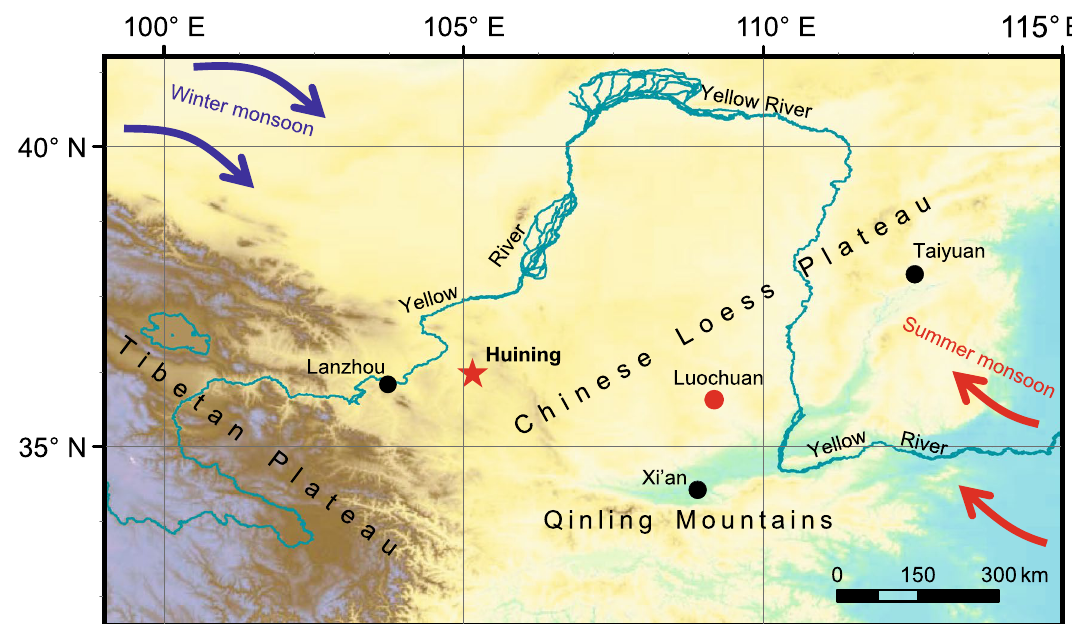
Figure 1. Locations of the Chinese Loess Plateau and the studied section. The red star denotes the location of the Huining loess–paleosol sequence. The black and red solid circles denote locations of major cities and the Luochuan section, respectively. The blue arrows indicate the direction of the East Asian winter monsoon, and the red arrows the East Asian summer monsoon. The base map of this figure was generated using DIVA-GIS 7.5 (http:// www. diva- gis.